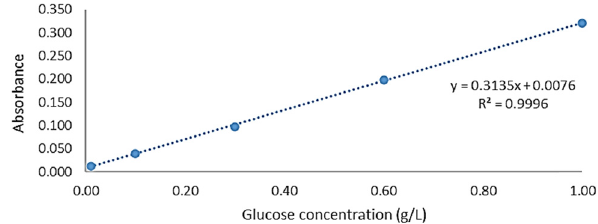
Figure 5: Glucose calibration at 590